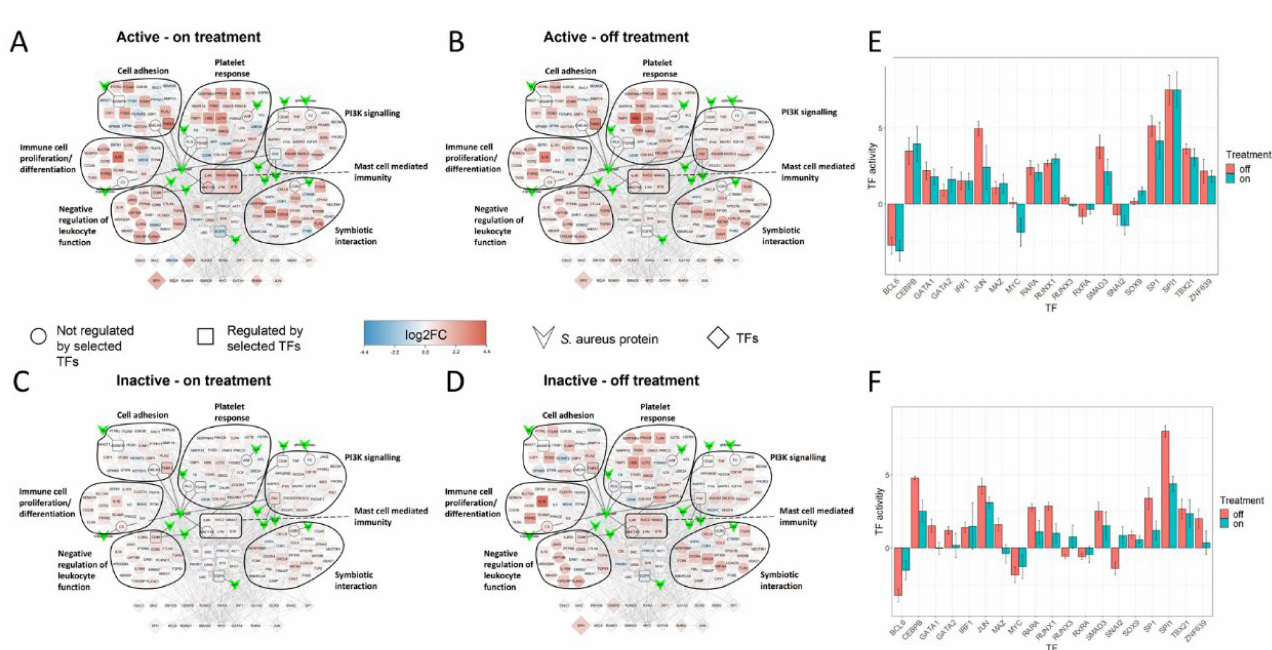
Figure 6. Comparison of SA-PR3+ AAV interaction network across different nasal disease and treatment groups. ( A – F ) Networks and bar charts are as defined in Figure 4. ( A , B ) Active nasal disease patients on and off treatment show little difference in expression suggesting genes in the network remain dysregulated despite being on treatment. ( C , D ) Inactive nasal disease patients show a reduction in differential expression for those on treatment. ( E , F ) TF activities for active/inactive and on/off treatment reflect the changes observed in the SA-PR3+ AAV interaction networks for the respective patient